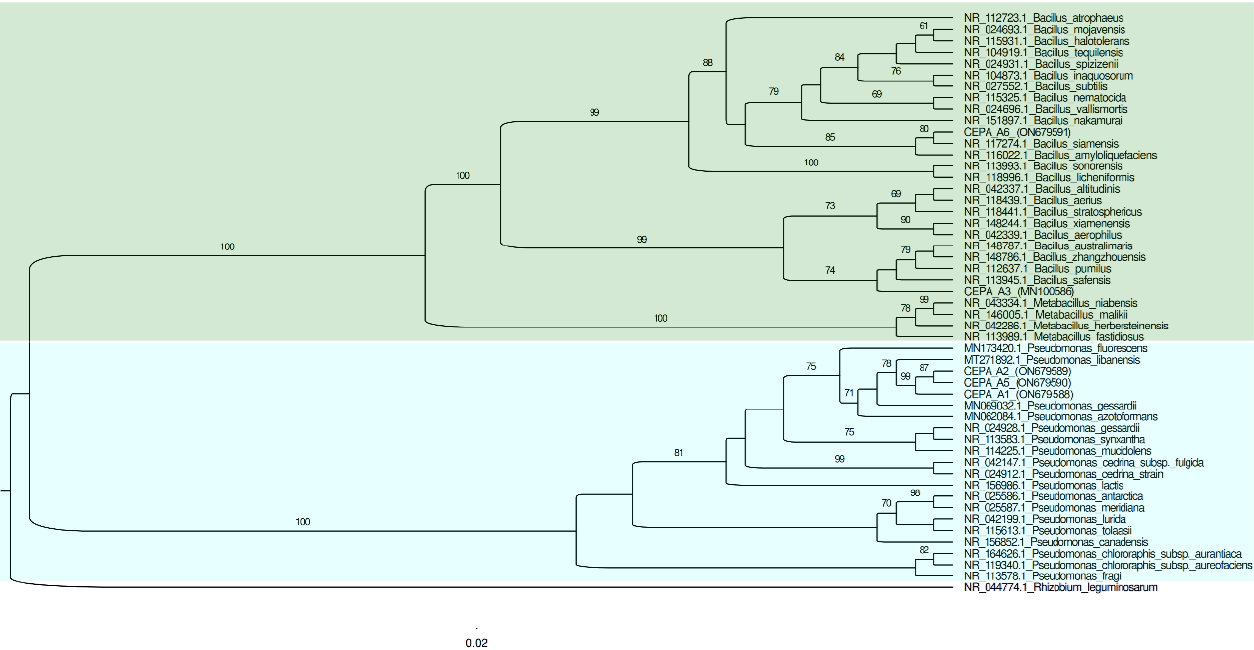
Figure 2. Phylogenetic tree of the 16S rRNA gene sequencing for all five bacterial isolates with the ability to solubilize phosphate. The reference sequence accession numbers are shown after the species name.